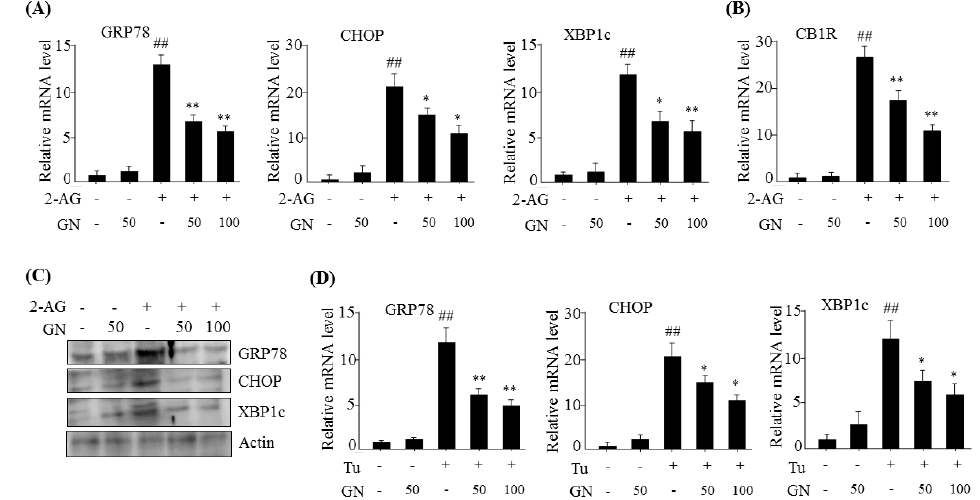
Figure 1. Gomisin N (GN) inhibited 2-AG-induced endoplasmic reticulum (ER) stress in HepG2 cells. HepG2 cells were incubated with 2-AG in the absence or presence of GN (50 or 100 µM) for 12 h. ( A ) qPCR analysis of GRP78 , CHOP , and XBP1c ; ( B ) qPCR analysis of CB1R ; ( C ) Western blot analysis of GRP78, CHOP, and XBP1c; ( D ) HepG2 cells were incubated with tunicamycin (Tu) in the absence or presence of GN (50 or 100 µM) for 12 h. qPCR analysis of GRP78 , CHOP , and XBP1c . Values are expressed as mean ± SEM ( n = 3 independent experiments). ## p < 0.01 vs. untreated control. * p < 0.05, ** p < 0.01 vs. 2-AG or tunicamycin-treated control.